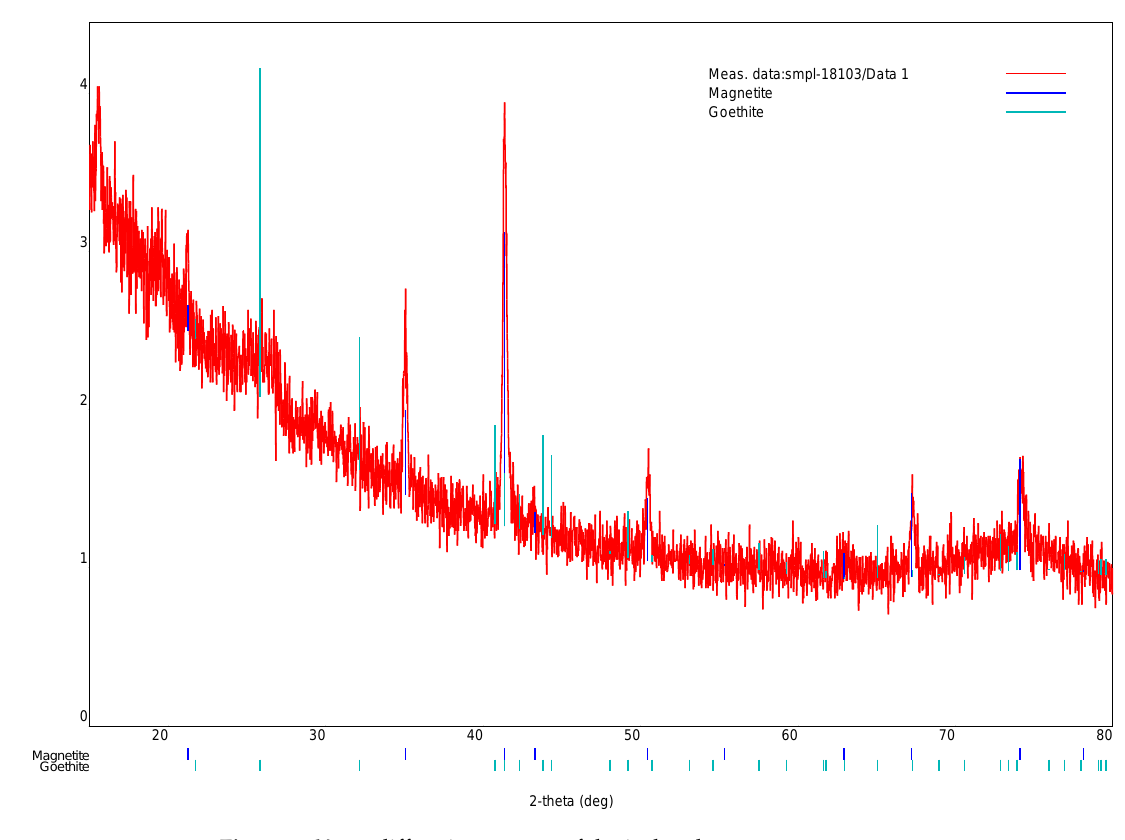
Figure 5. X-ray diffraction pattern of the isolated magnetosomes.